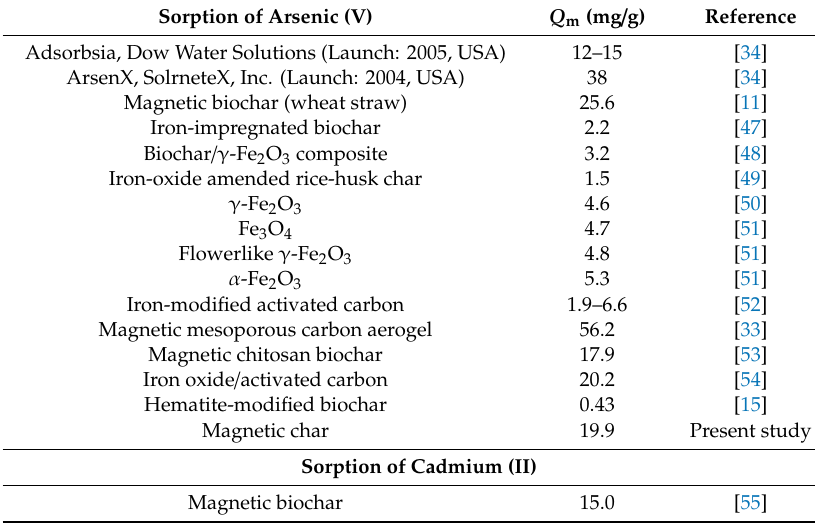
Table 5. Comparison of maximum sorption capacity ( Q m ) of arsenic and cadmium for the magnetic carbons, iron oxides, and commercial